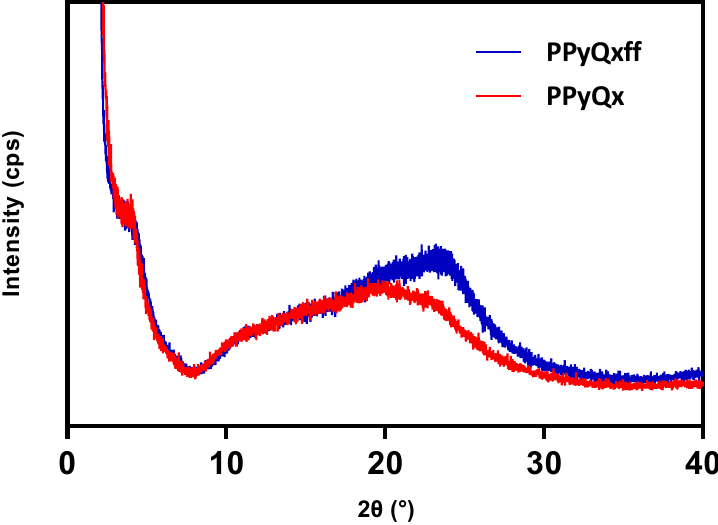
Figure 4. XRD patterns of PPyQxff and PPyQx.